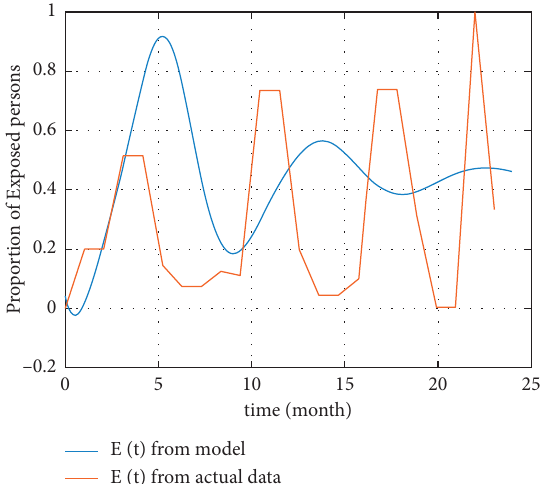
Figure 18: Proportion of exposed curves from smoothing by bin boundaries data and the model.